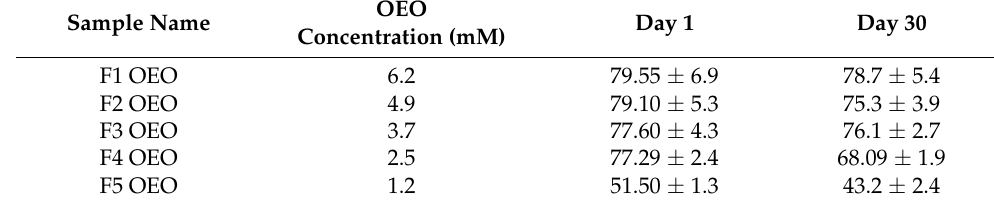
Table 3. Entrapment efficiency percentage (EE%) of OEO at different concentrations after 1 day and 1 month of storage at 4 °C. Data are expressed as mean values ± standard deviation.